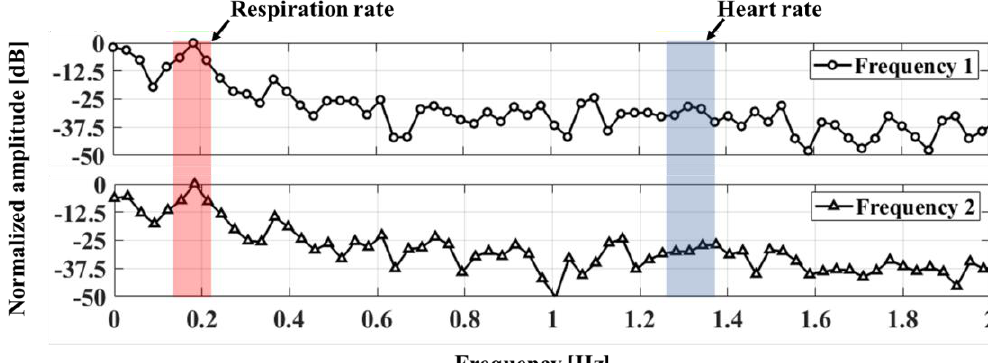
Figure 11. Spectra of the vital signals measured at a distance of 1 m using the proposed FSK radar.